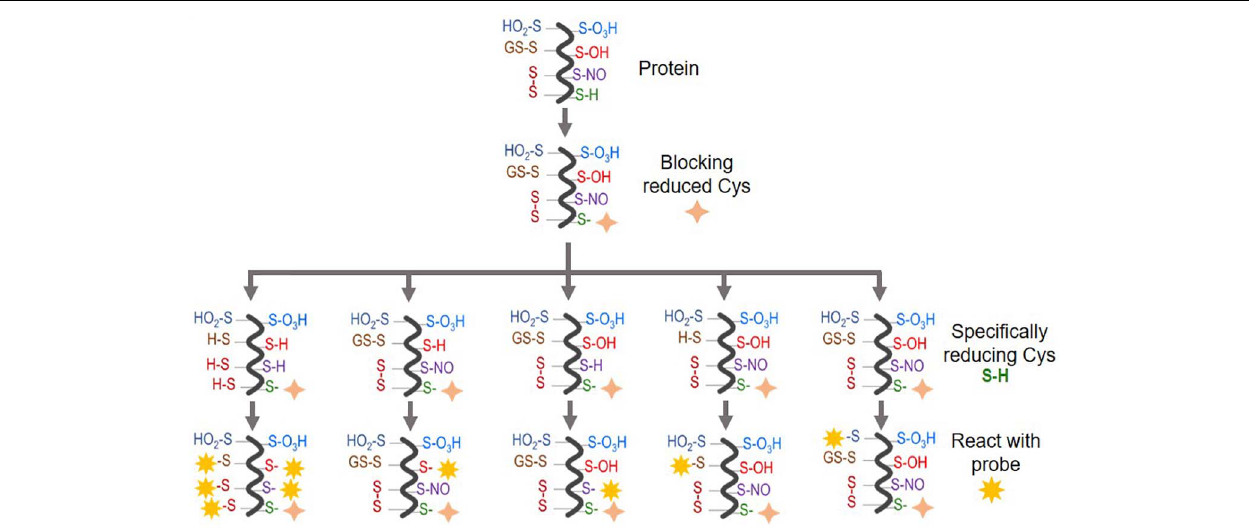
FIGURE 2 | An overview of Oxi-Cys quantitative proteomics approaches for different types of Cys oxidations. Chemicals used for selective Oxi-Cys proteomics analysis. Free reduced Cys residues are firstly labeled with alkylating reagents (IAM, NEM, MMTS, etc. ) while different PTMs of reversible Oxi-Cys residues are selectively alkylated by specific reducing regents; for example, DTT/TCEP for reducing all reversible Cys, arsenite for S -sulfenylation ( S -OH), ascorbate for S -nitrosylation ( S -NO), glutaredoxin for S -glutathionylation ( S -SG). These newly formed reduced Cys residues then, theoretically, can be labeled by different alkylating reagents or specific probes coupled with tags for purification/enrichment. The quantitation is performed based on comparing intensities of tags from diseased compared to control groups. S -OH probes include: dimedone and bicyclononyne BCN; S -O 2 H probes include: C -nitroso esters, diazenes and S -nitrosothiols as detailed in Figures 5A,B